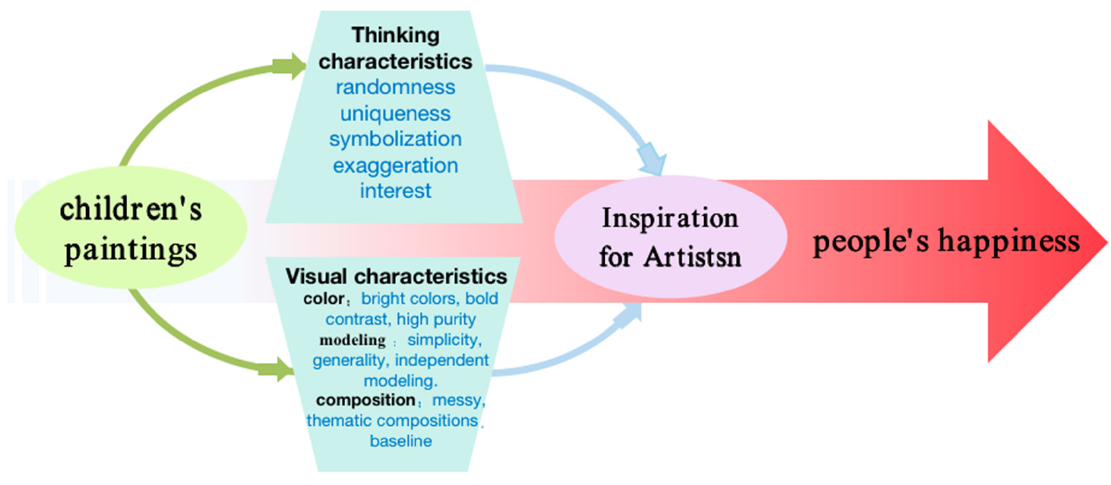
Figure 2. Proposed conceptual framework for influence of children’s paintings’ features on people’s well-being.